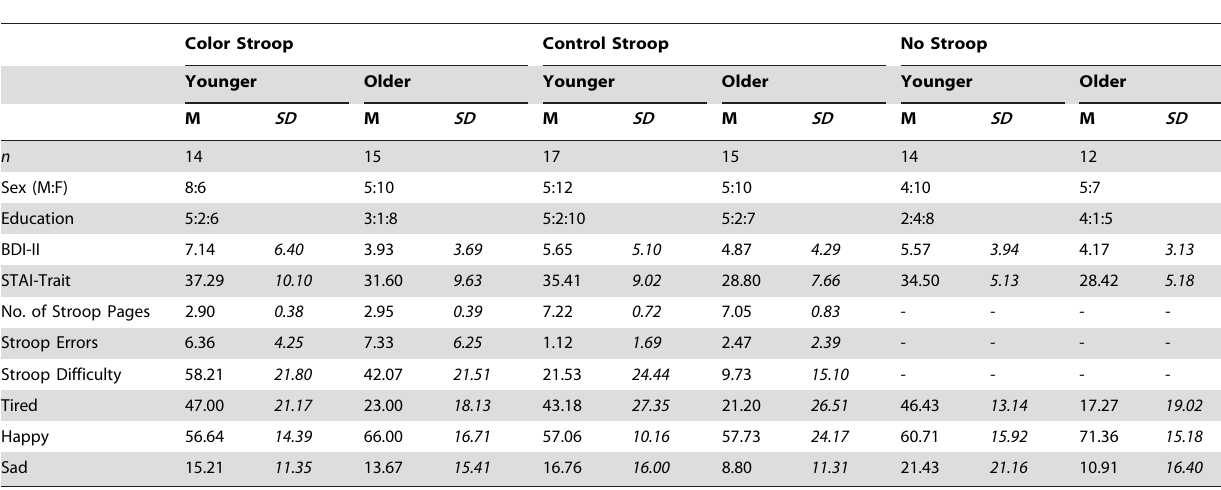
Table 1. Participant Characteristics and Stroop Task Data Across the Three Experimental Conditions and two Age Groups.